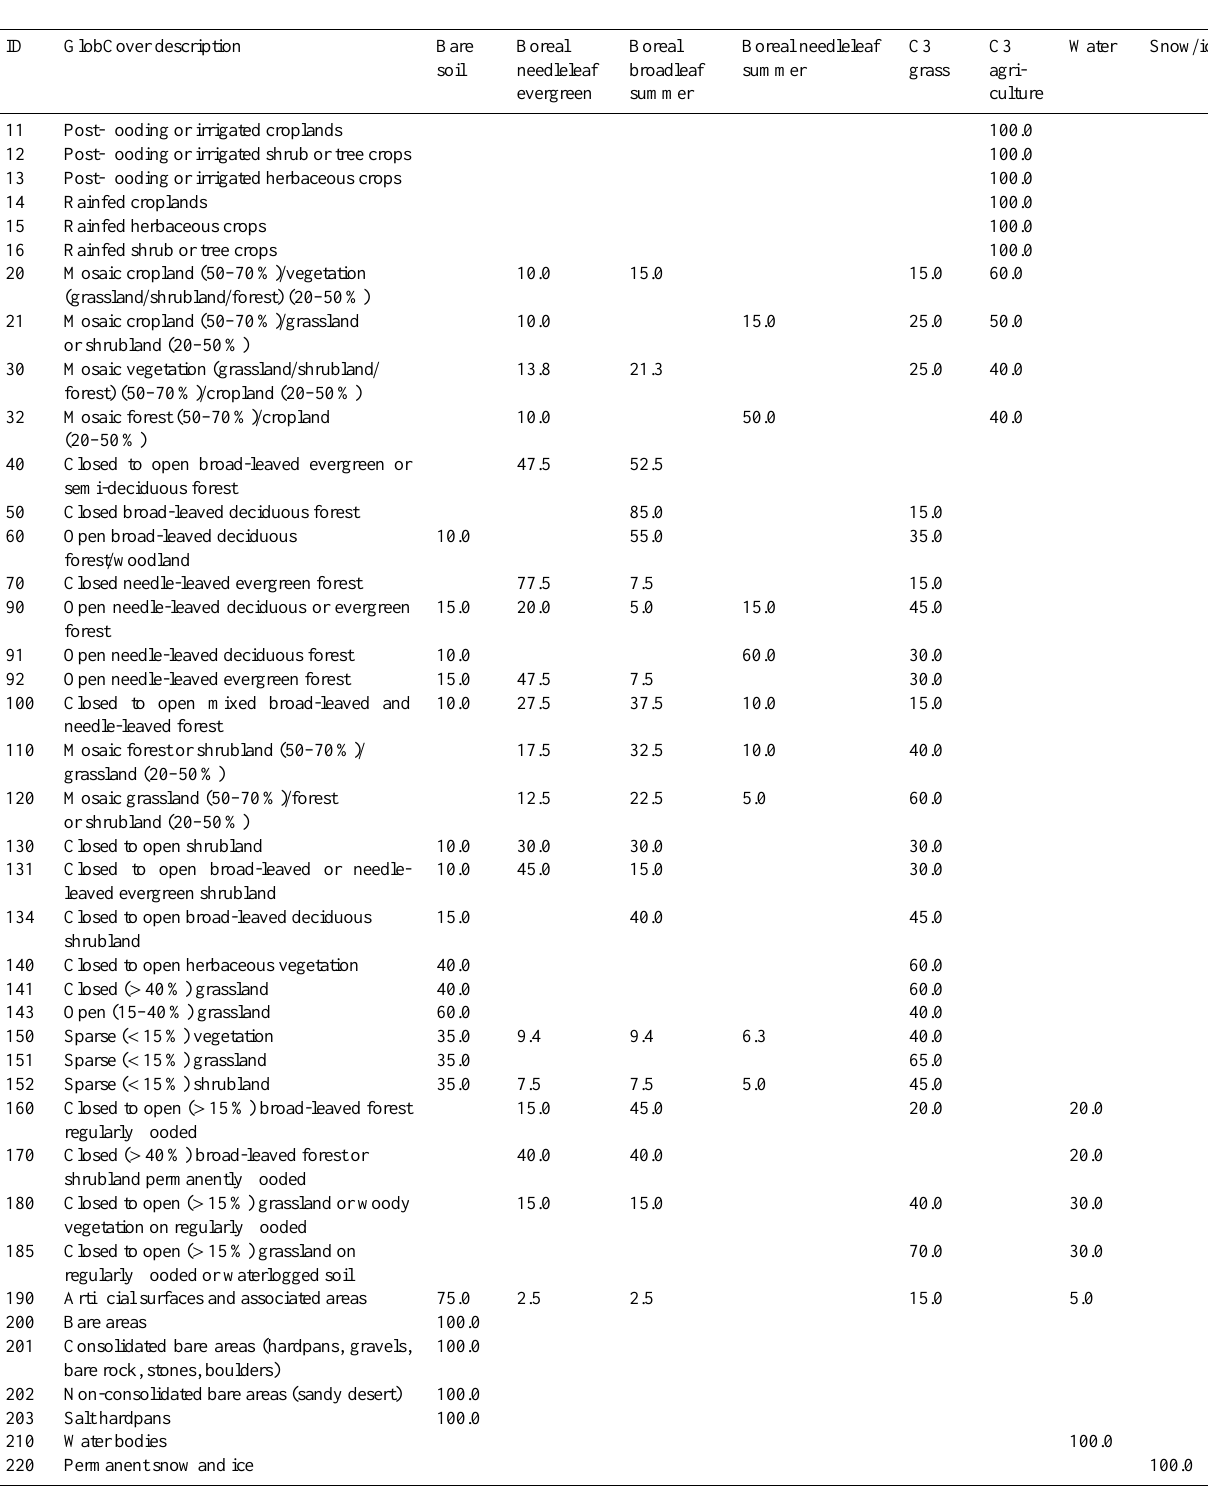
Table 8. Merging rules from GlobCover classes to ORCHIDEE